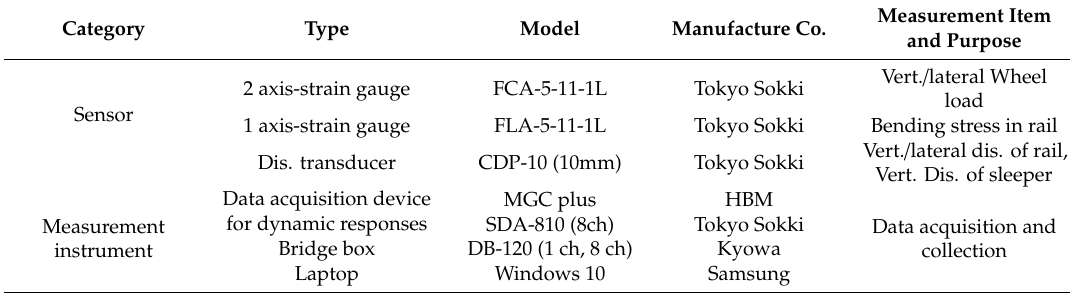
Table 6. Field instrument equipment list.